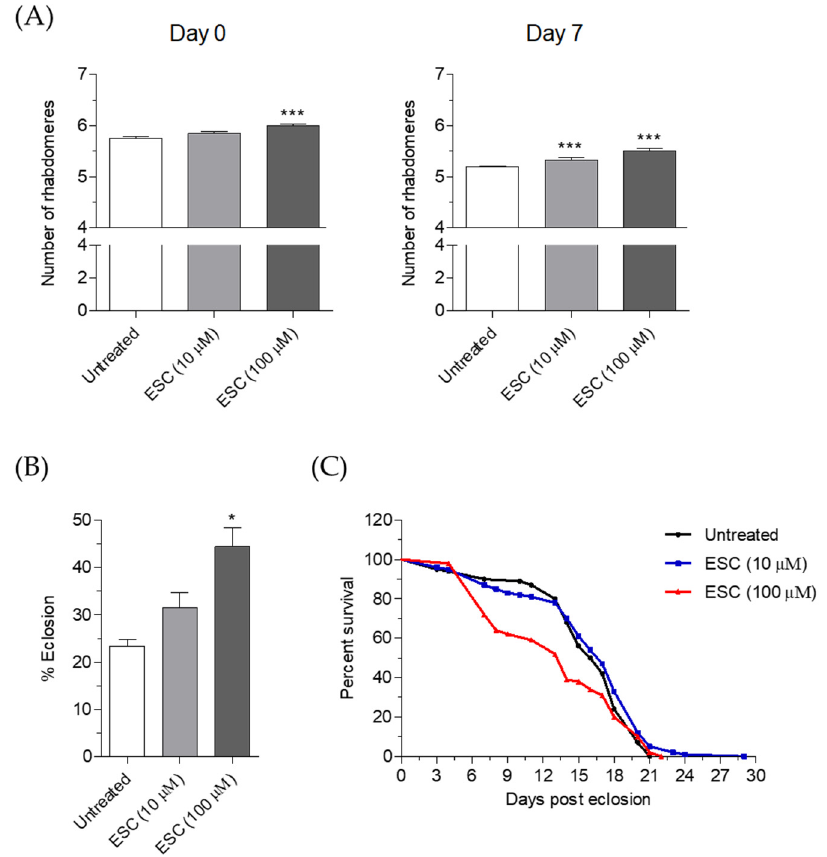
Figure 8. ESC ameliorates neurodegeneration in transgenic HTT93Q flies. ( A ) Drosophila expressing HTT93Q exon 1 pan-neuronally were fed with ESC at different concentrations during development and as adults. Rhabdomeres were scored via the pseudopupil assay at day 0 (newly emerged flies) and at day 7 (adult flies) post eclosion as described in the Materials and Methods. Data are expressed